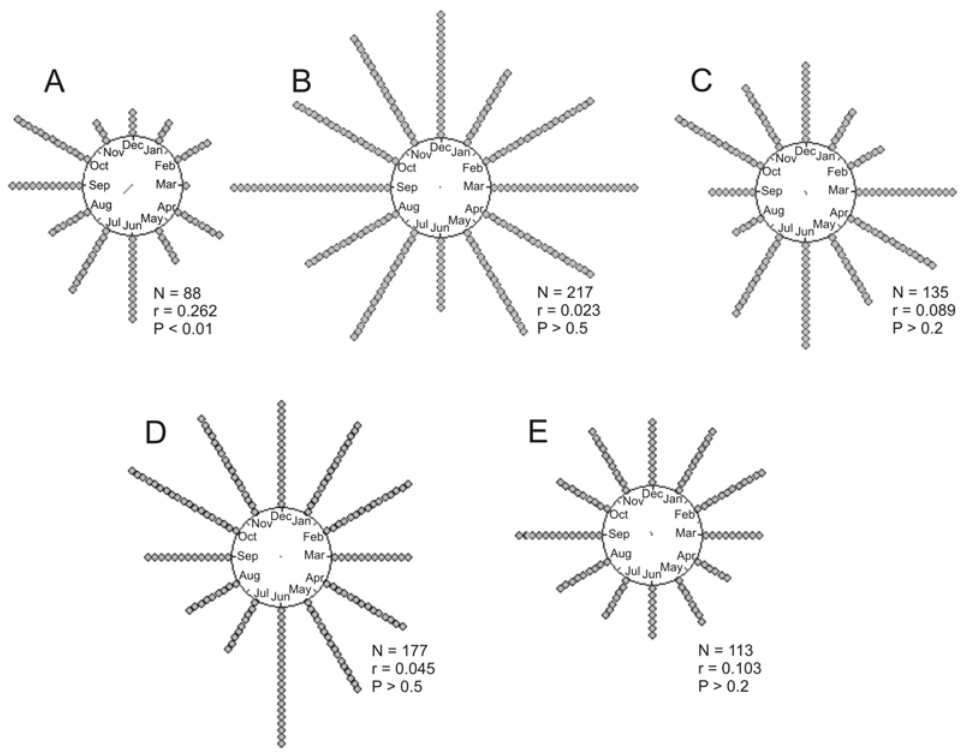
Fig. 2 – Distribution of positive responses (gray dots) to the playback during one year of surveys and Rayleigh’s test results. A : B. cinerea ; B : B. leucoblepharus ; C : T. surrucura ; D : C. caudata ; E : P. leucoptera . N: number of playback sessions; r: concentration level, P: significance